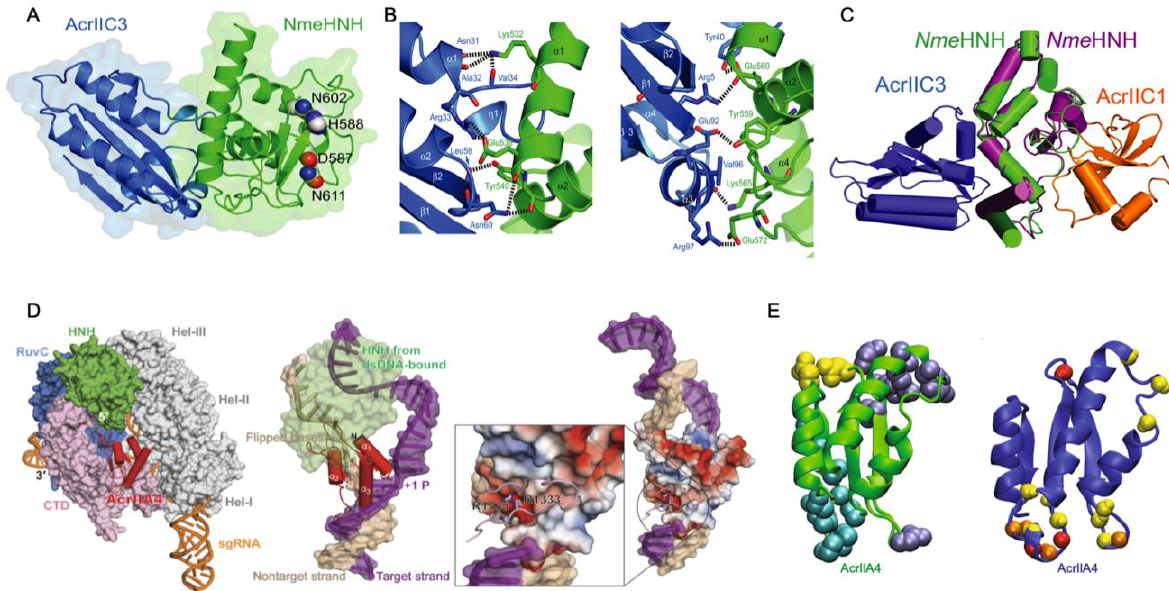
Figure 1. Direct interaction of Acrs with Cas nucleases. ( A ) Structure of AcrIIC3 (blue) bound to Nme HNH (green) at an interface opposite the active site pocket (residues shown as spheres). ( B ) Interaction interface between AcrIIC3 (blue) and Nme HNH (green) showing intermolecular hydrogen bonds and salt bridges. ( C ) Demonstration of a plausible dual-Acr ternary complex via the structure of AcrIIC3- Nme HNH (blue, green) superimposed onto the structure of AcrIIC1- Nme HNH (orange, purple, PDB 5VGB). ( D ) Superposition of the AcrIIA4-bound Sp Cas9 structure with DNA-bound Sp Cas9 showing AcrIIA4 blocking DNA recognition at the PAM binding pocket (left). Superposition of the AcrIIA4-bound Sp Cas9 structure with Sp Cas9-gRNA-dsDNA (PDB 5F9R) showing PAM recognition residues buried in an AcrIIA4 acidic pocket (middle, right). ( E )